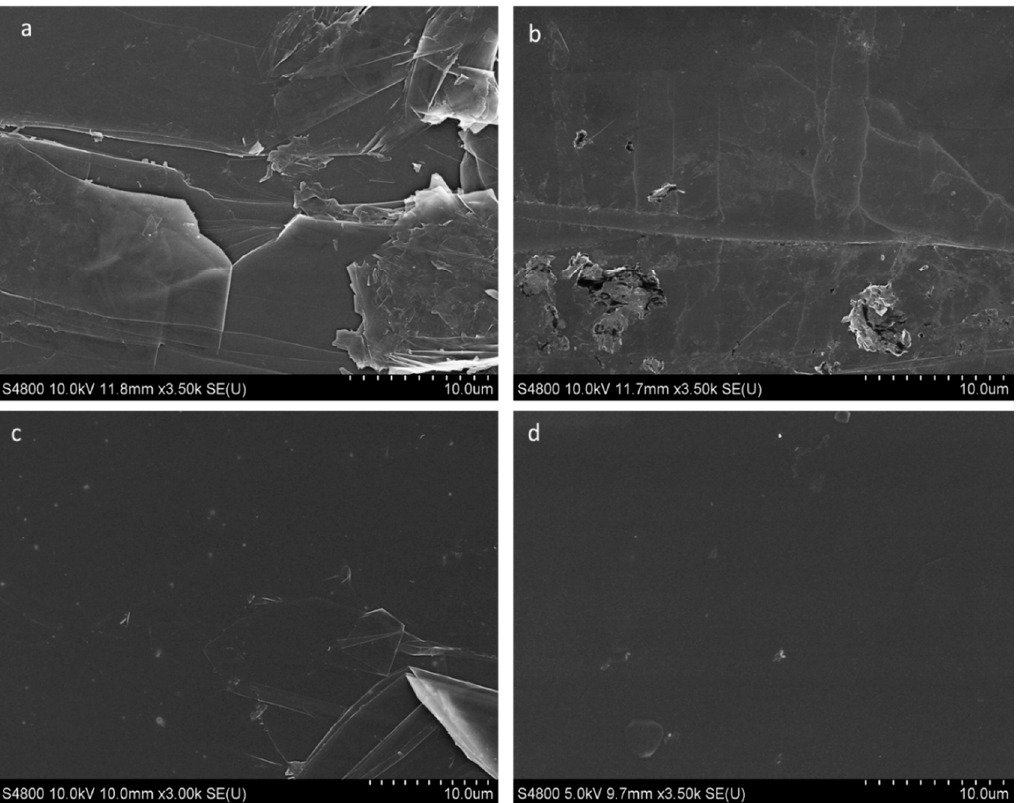
Figure 7. Morphology of HOPG electrode with scanning electron microscopy (SEM). ( a ) blank—before diazotisation, ( b ) after diazotisation—one scan, ( c ) after three scans, ( d ) after five scans.